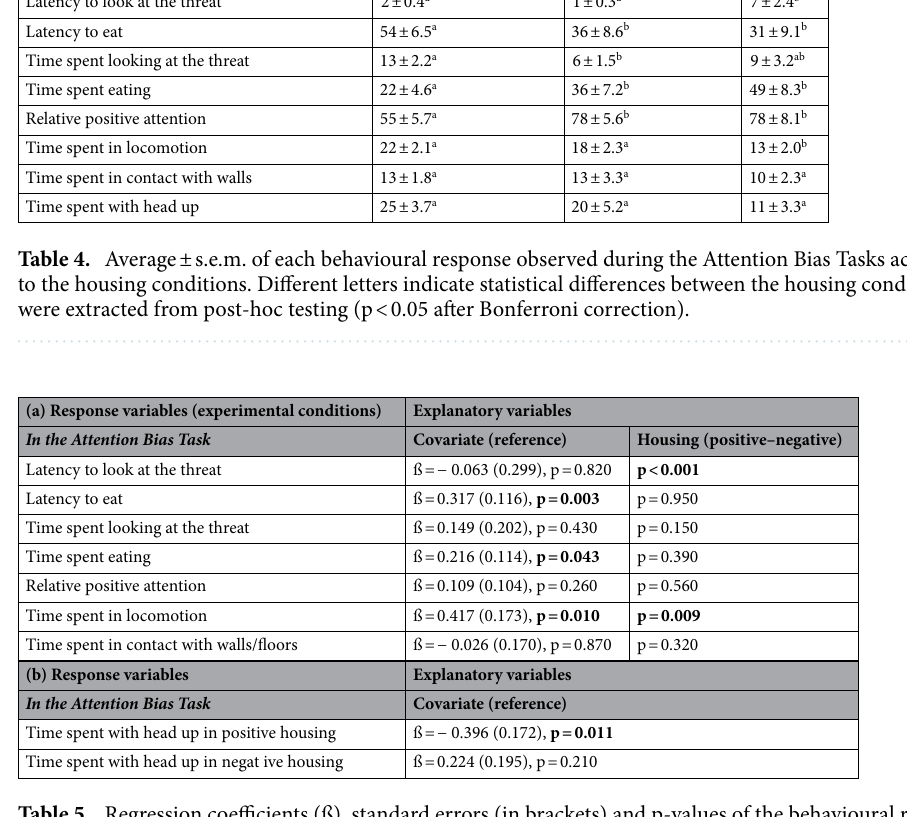
Table 5. Regression coefficients (ß), standard errors (in brackets) and p-values of the behavioural responses measured during the Attention Bias Tasks in the experimental conditions in relation with their respective measures (covariates) in the reference conditions. (a) Presents the parameters of the equation lines for both levels of housing, when no significant interaction between the covariate and housing were found. (b) Presents the parameters of the equation line for each level of housing, when an interaction between the covariate and housing was found. Significant values are in bold.